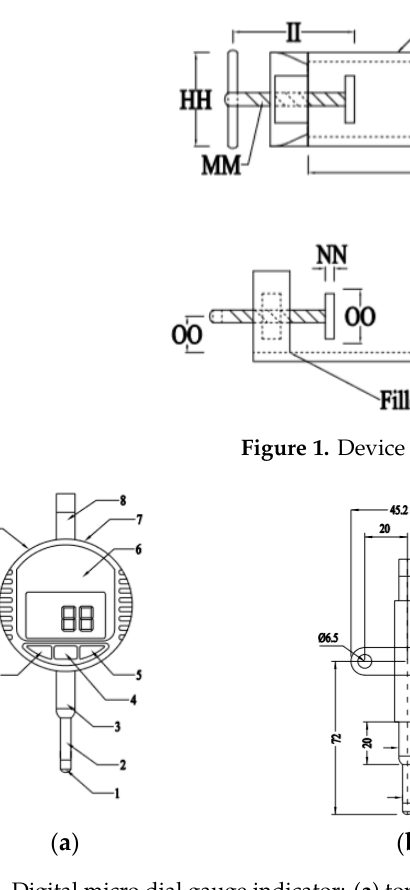
Figure 2. Digital micro dial gauge indicator: ( a ) top view, ( b ) side view, ( c ) top view of real equipment.